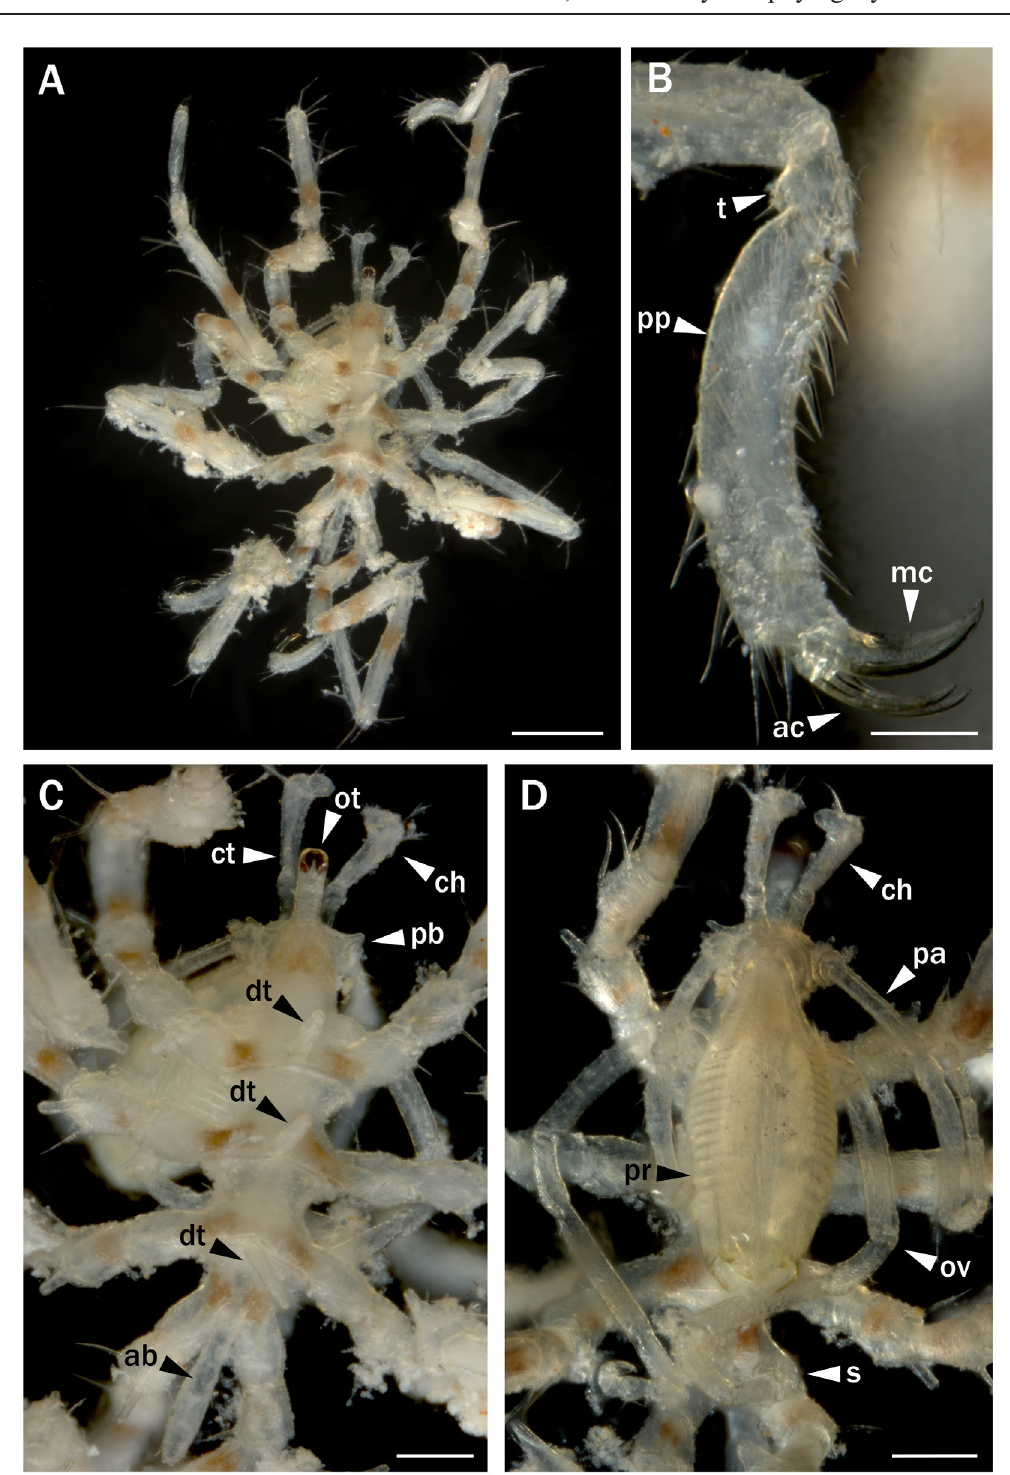
Fig. 6. Teratonotum stauromatum (Child, 1982) gen. et comb. nov. (MNHN-IU-2013-17964). A . Dorsal view. B . Propodus of third leg. C . Dorsal view of body. D . Ventral view of body. Abbreviations: ab = abdomen; ac = auxiliary claw; ch = chelifore; ct = chelifore tubercle on the anterior tip of the first scape; dt = dorsal tubercle; mc = main claw; ot = ocular tubercle; ov = oviger; pa = palp; pb = bulbous tubercle bearing the palp; pp = propodus; pr = proboscis; s = strigilis; t = tarsus. Scale bars: A = 0.5 mm; B = 0.1 mm; C–D = 0.2